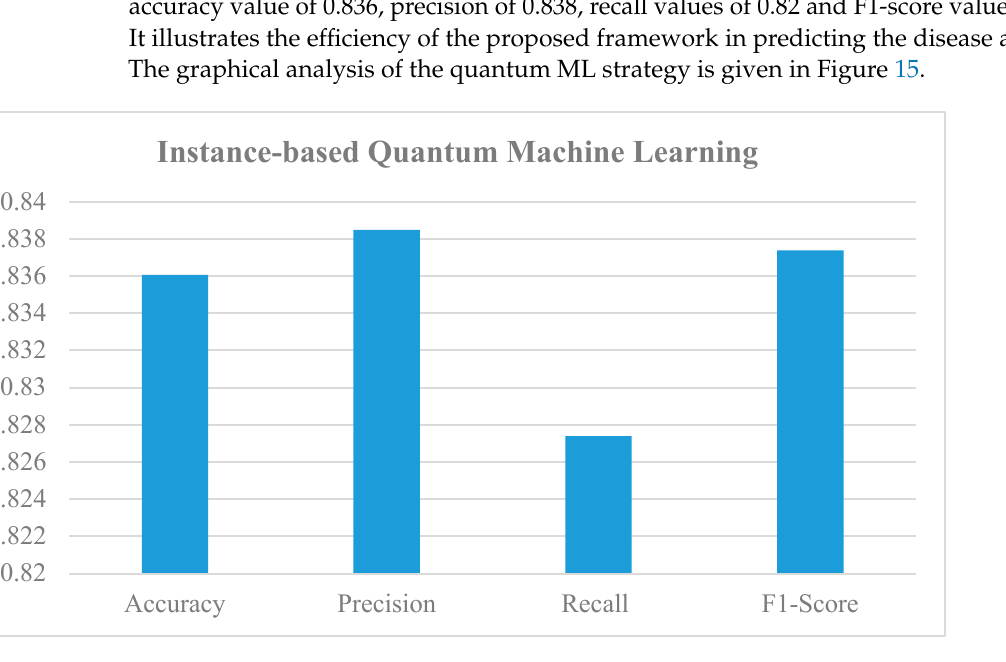
Figure 15. Graphical performance analysis of proposed QML.